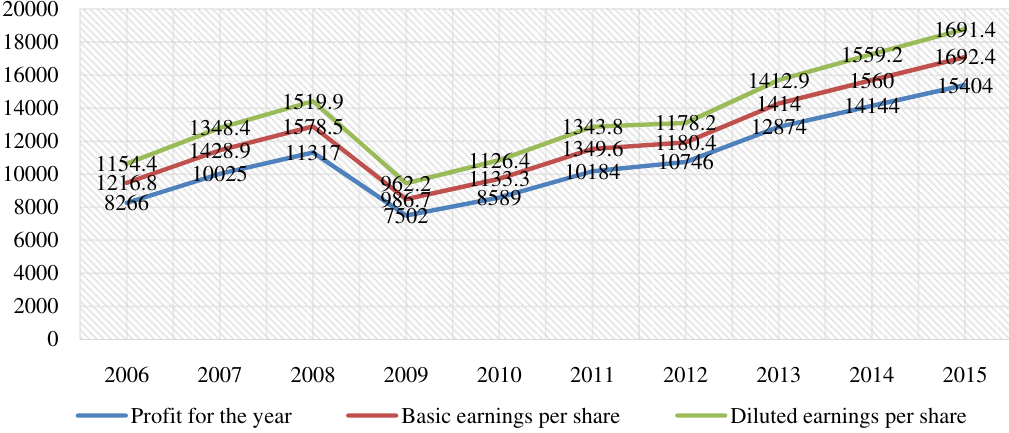
Fig. 1. The financial performance of the acquired Amalgamated Bank of South Africa for the period 2006-2015 Source: audited consolidated and separate financial statements of ABSA/Barclays South Africa.